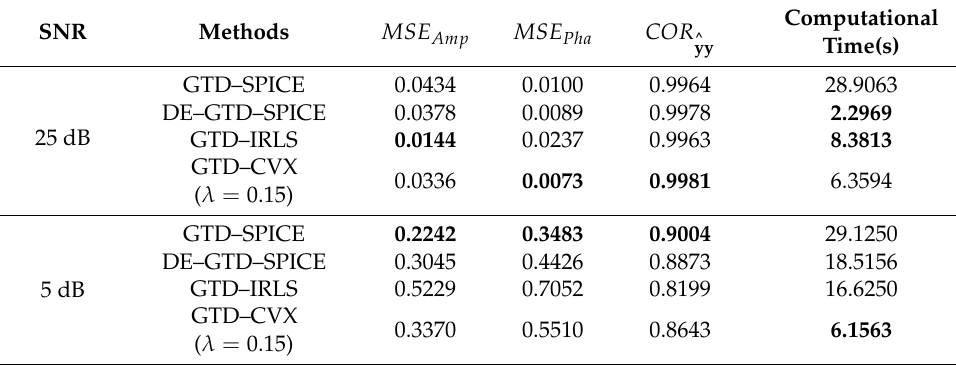
Table 3. Numerical results under different SNR